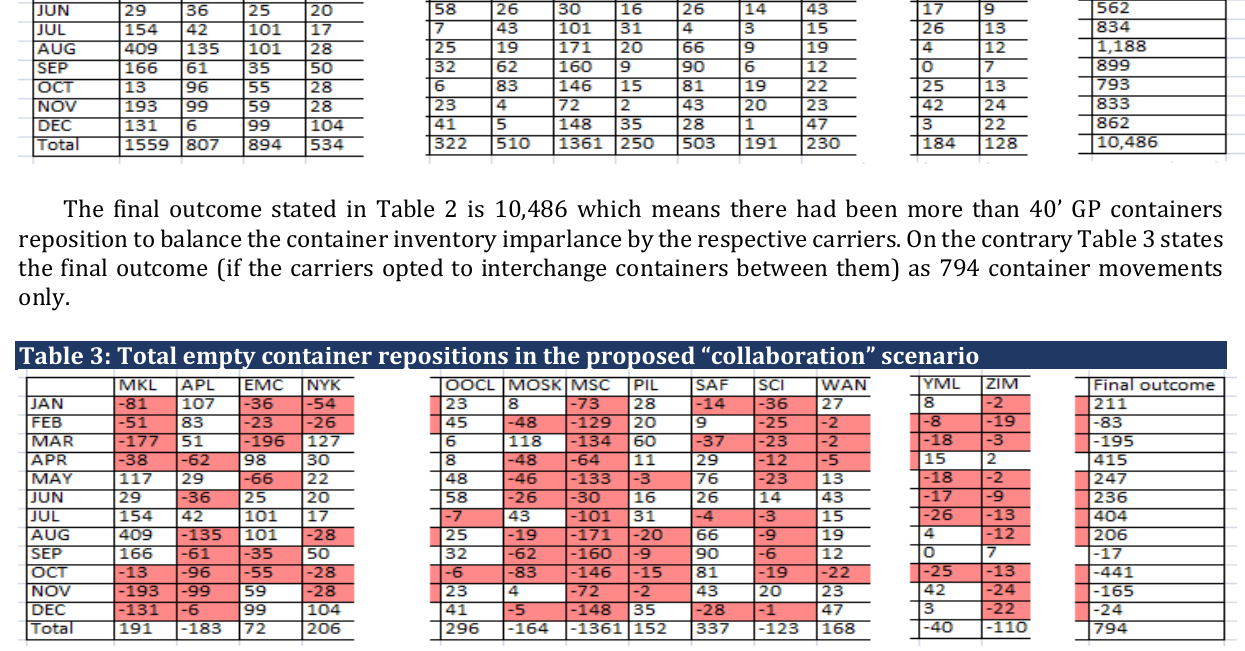
Key: shaded boxes with (-) in front of the number indicate deficit inventory while clear boxes denote excess inventories Therefore, the difference between these two outcomes (i.e. 9692 container movements) reveals the saving that could generate through collaboration. In order to rightly calculate the financial benefits of the